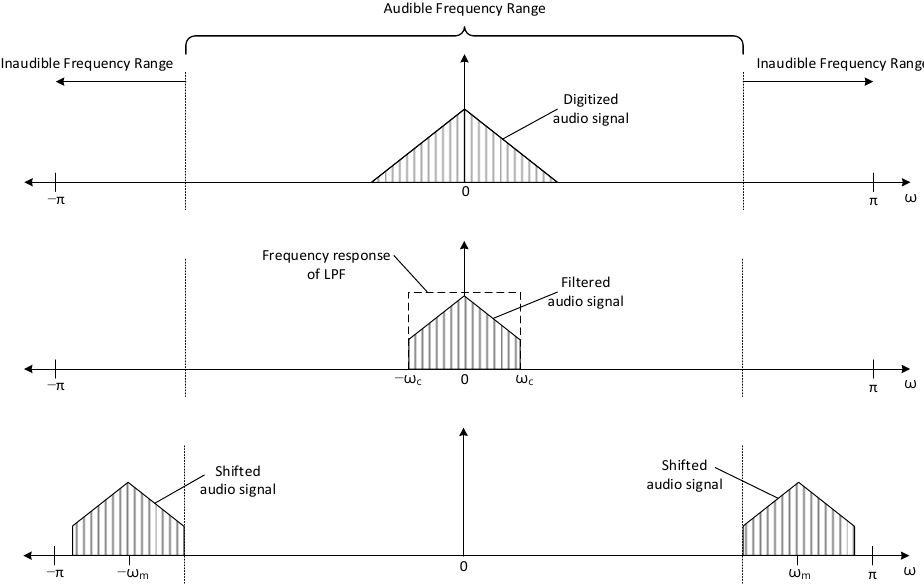
Figure 5. Frequency distribution of the individual transmitter block.